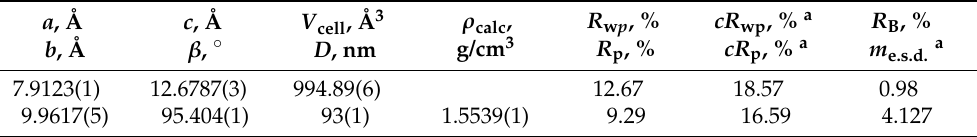
Figure 3. Final graphical results of Rietveld fitting of the MBI-perchlorate (space group P 2 1 / n (14)) powder XRD pattern. The Bragg angle positions of all allowed reflections are shown by bar diagram. Miller indices hkl are indicated for some selected reflections (a list of hkl and squares of observed ( F hkl_obs2 ) and calculated ( F hkl_calc2 ) structure amplitudes as calculated by TOPAS is given in Supplementary Materials in a separate text-file with extention ‘fcf’). Table 3. MBI-perchlorate ( T meas = 313±1 K). Monoclinic unit cell parameters ( a , b , c , and β ), unit cell volume V cell , mean crystallite size D , and reached agreement factors [55] obtained in Rietveld refinement and the factor m e.s.d. for correction of e.s.d.s of refined parameters.